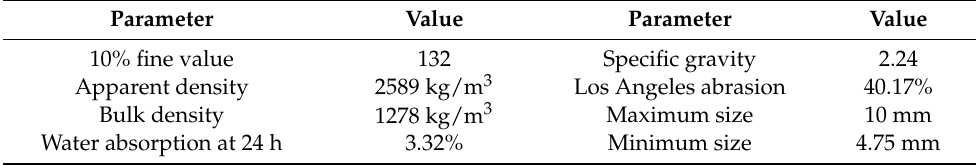
Table 1. Several features of coarse